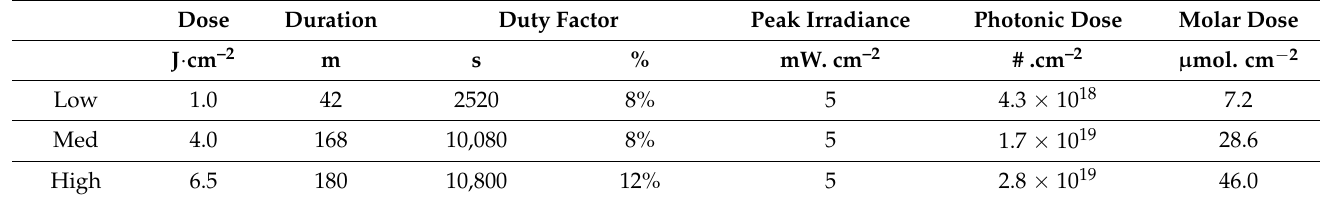
Table 1. Dosimetry overview. # refers to ‘number of